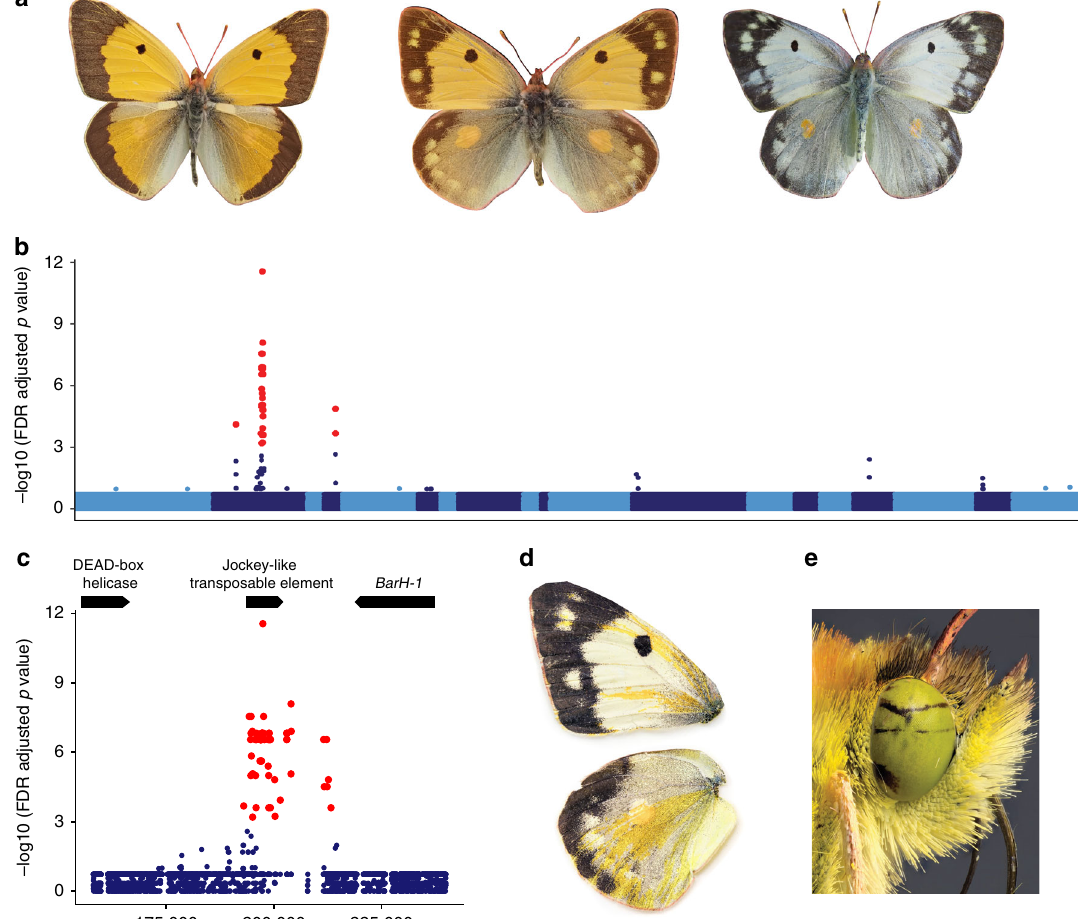
Fig. 1 Color variation in Colias crocea and the genetic mechanism of Alba. a Colias crocea male, orange female, and Alba female (left to right). b SNPs signi fi cantly associated with the Alba phenotype (red) within the ~3.7 Mbp Alba locus identi fi ed via three rounds of bulk segregant analysis. Contigs in this region shown as alternating dark and light blue. c The location of Alba-associated SNPs (red) on the ~430 kb outlier contig identi fi ed in the GWAS. Gene models for the DEAD-box helicase, the Jockey-like transposable element, and BarH-1 shown at the top of the panel. d Wings of a female with an Alba genotype following CRISPR/Cas9 mosaic knockout of BarH-1 , wild-type regions are white, knockout regions are orange. Orange color is seen on the dorsal forewing (top) and hindwing (bottom). e BarH-1 mosaic knockout also leads to black regions in the eyes, wild-type regions are green. Source data are provided as a Source Data fi le. Panel d and e photo credit John